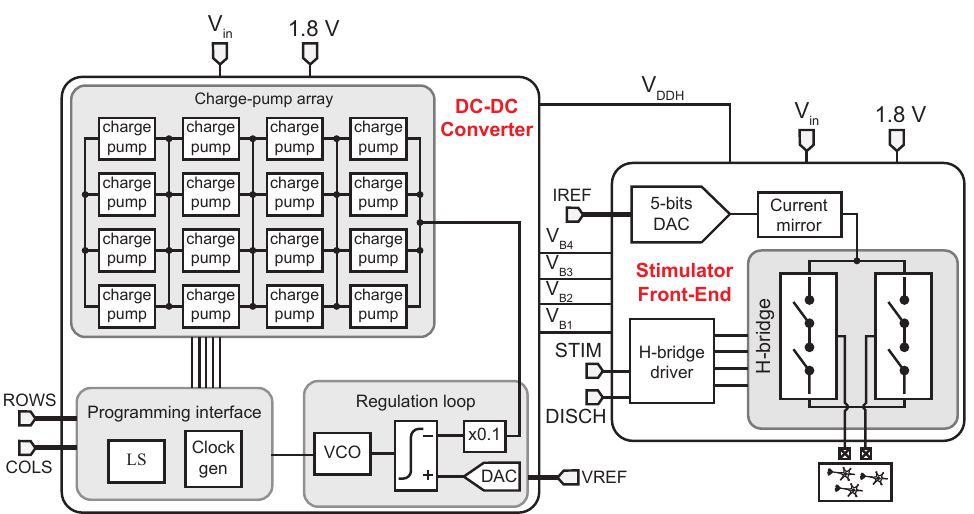
Figure 3. Block-level scheme of the proposed HV neural stimulator.